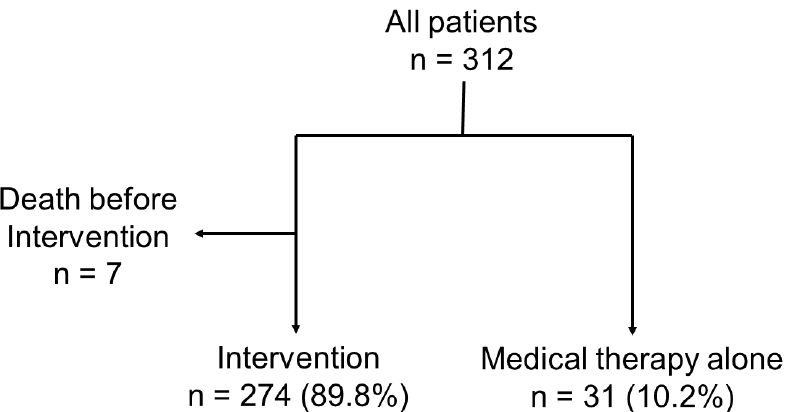
Figure 1. Study flow chart. The present study included 274 patients (89.8%), who underwent mitral Figure 1. Study fl ow chart. valve interventions and 31 (10.2%) were treated with medical therapy alone.